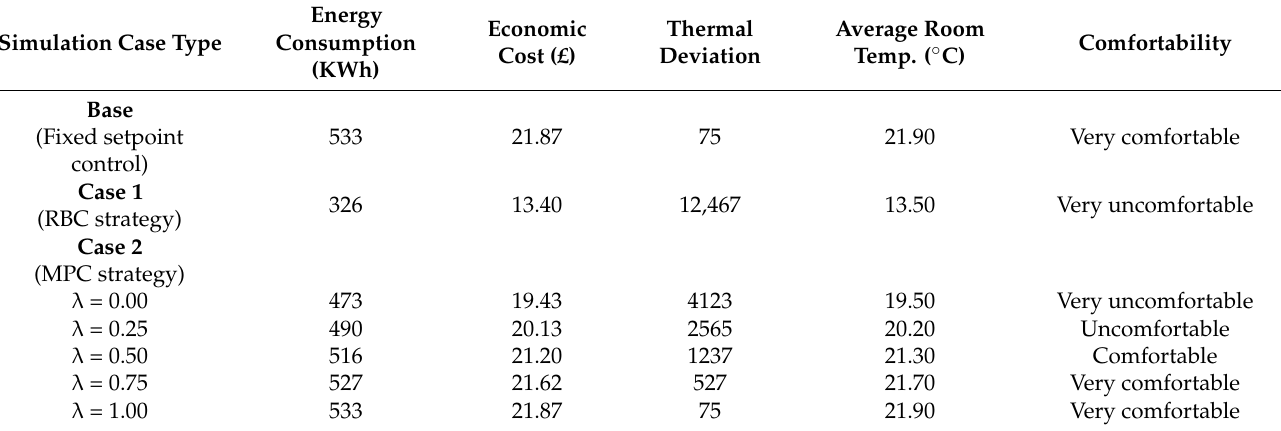
Table 3. Summary of results for all three simulation cases and